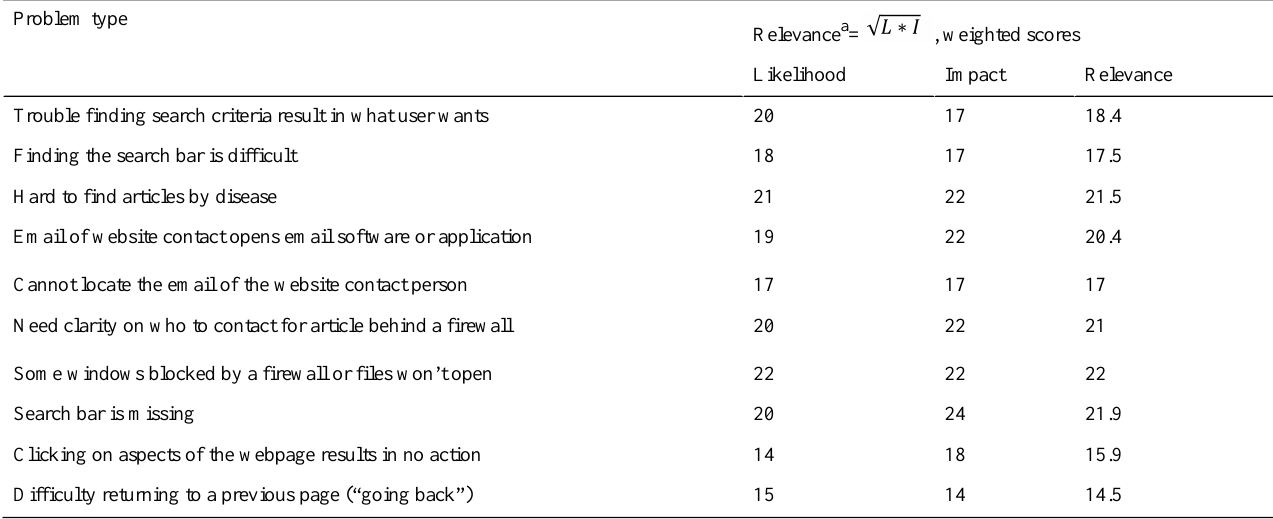
Table 4. Relevance of each problem type